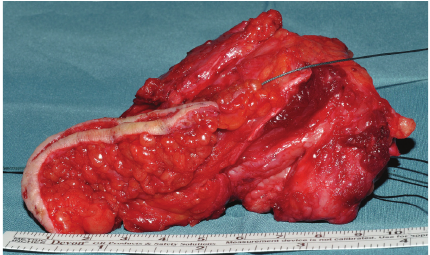
Figure 5: Resected tumor including skin and scar of biopsy.